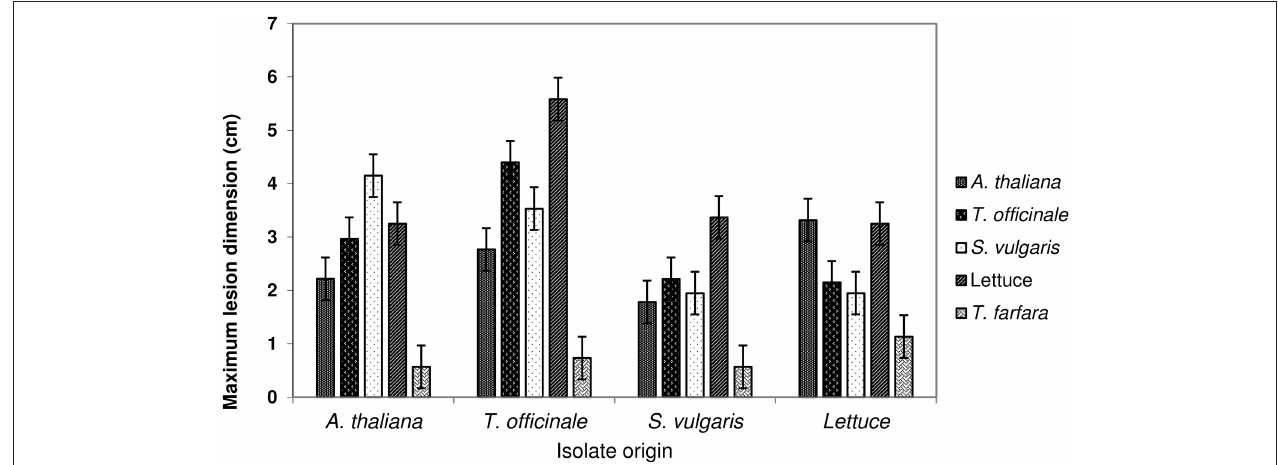
FIGURE 3 | Lesion diameters 5 days after agar plug inoculations of isolates of Botrytis sampled from four hosts onto entire detached leaves of Arabidopsis thaliana, Taraxacum officinale, Senecio vulgare, cultivated lettuce, and Tussilago farfara . Error bars represent 1 SED ; non-overlapping bars are different at P = 0 .05 (uncorrected for multiple